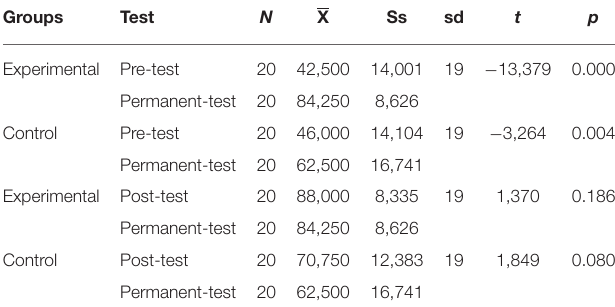
TABLE 2 | The pre/permanent-test and the post/permanent-test results by both the experimental and control groups.